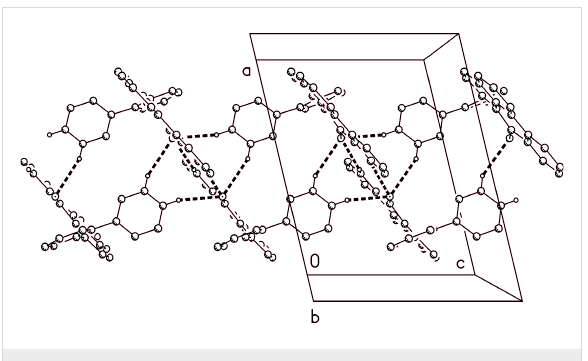
Figure 3: Packing diagram of compound 7 viewed parallel to b ; hydrogen bonds C-H···O are indicated by dashed lines.